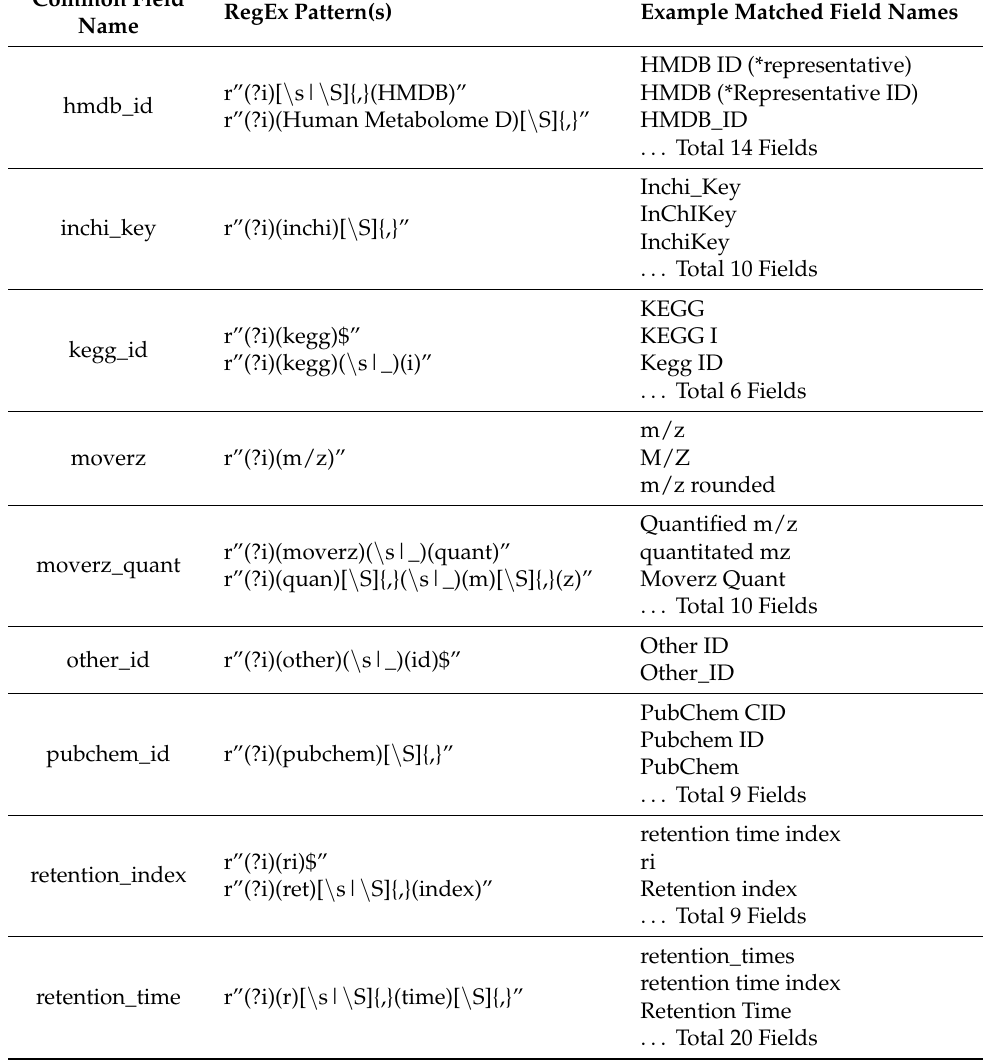
Table 4. List of common metabolite metadata headings from ‘METABOLITES’ blocks of MS and targeted NMR analyses, Regular Expressions (RegExs) used to match field names, and examples of similar/matching fields present in analysis files. See Supplemental Table S2 for a full list of matched field